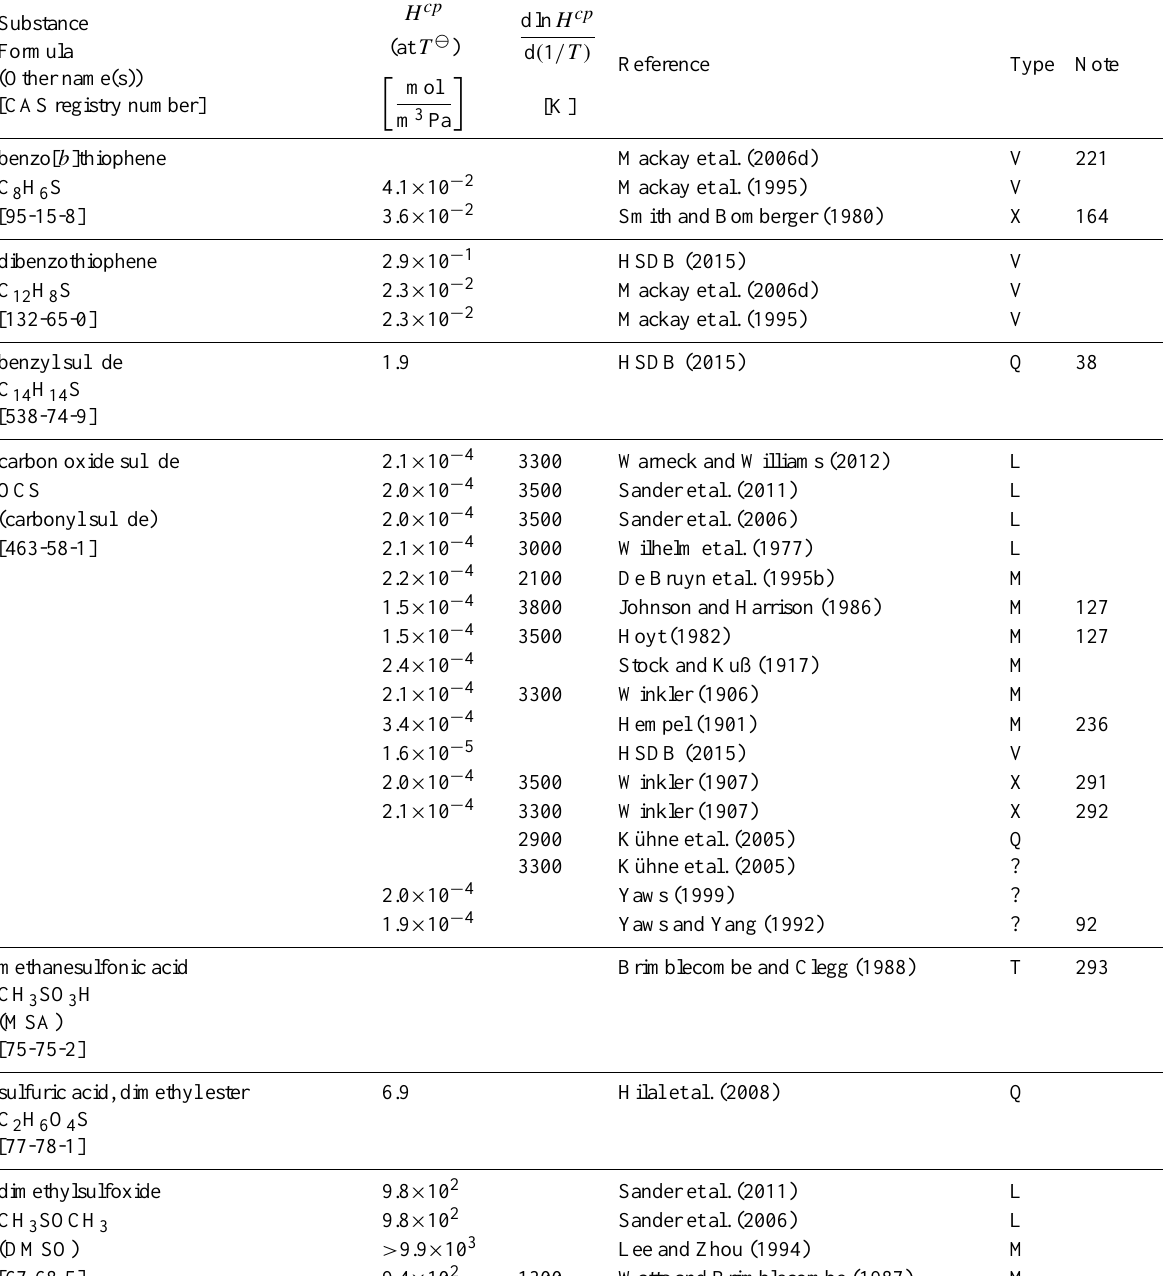
Table 6: Henry’s law constants for water as solvent